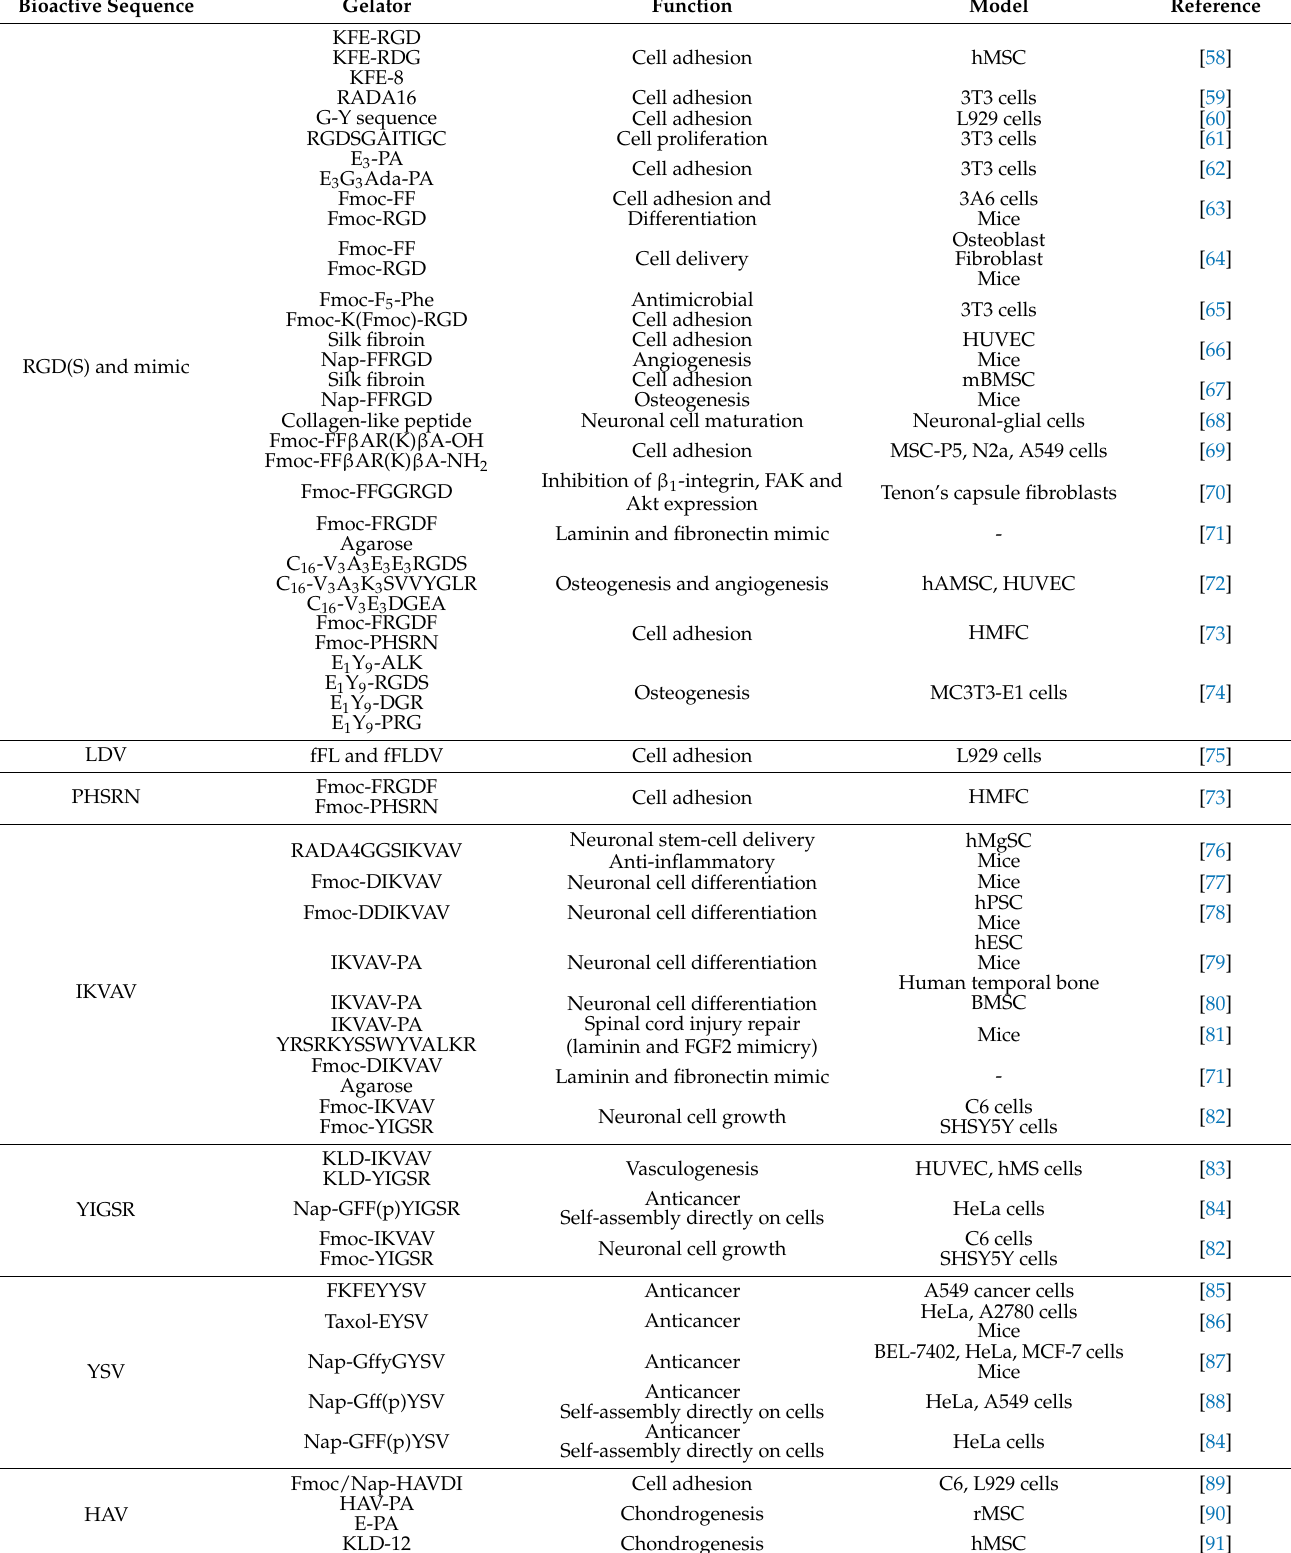
Table 1. Latest reported supramolecular peptide-based hydrogels with bioactive